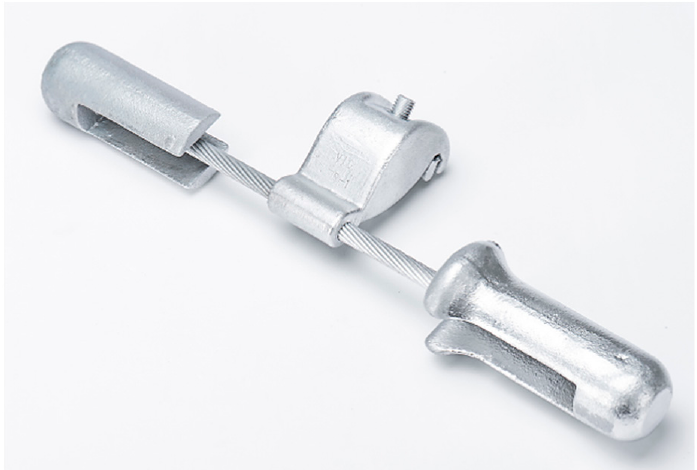
Figure 22. FR-3 Stockbridge damper. (Left: Small damper mass. Right: Big damper mass.)